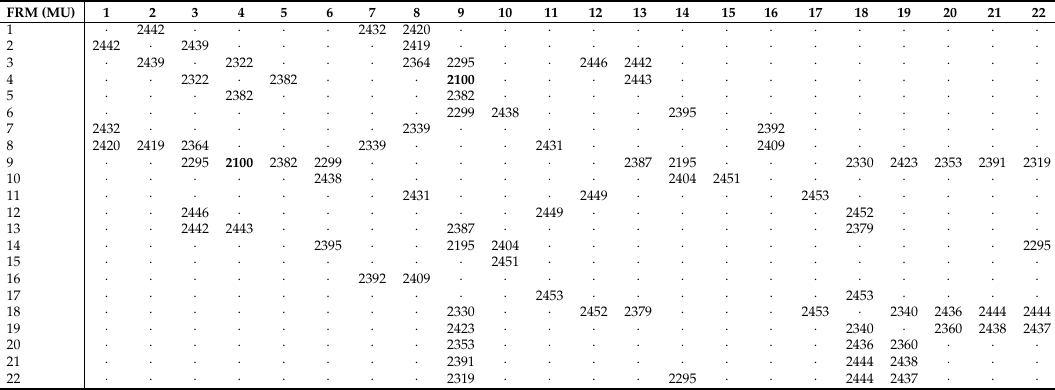
Table 4. FRM after locating a firebreak between two sectors. Minimum value is highlighted in bold.